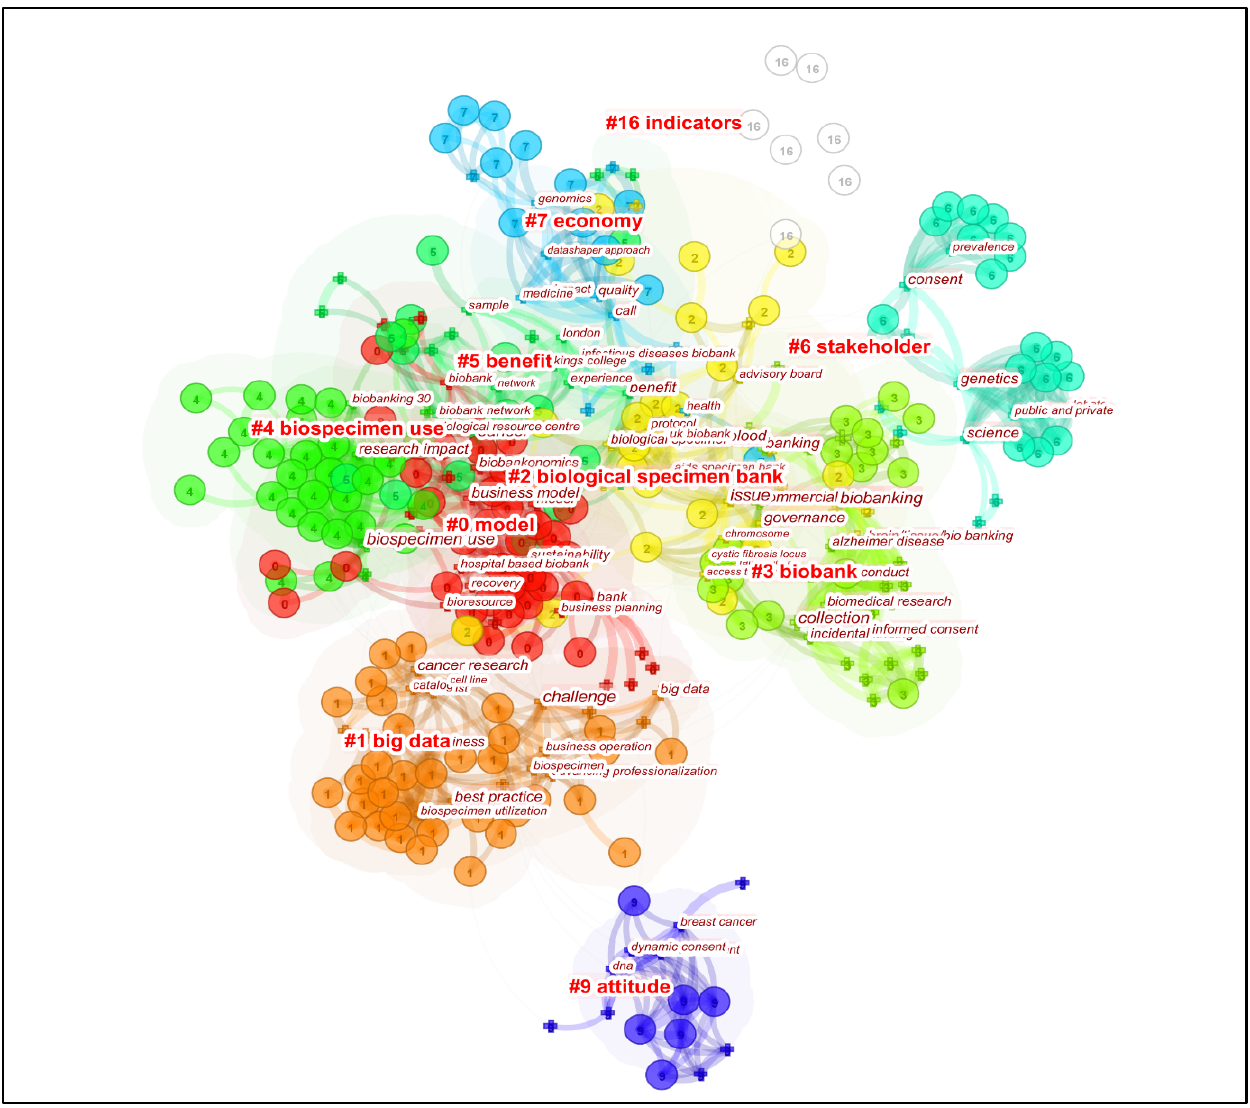
Figure 3. Network overview of 165 articles on biobank business and economics. Cluster labels by